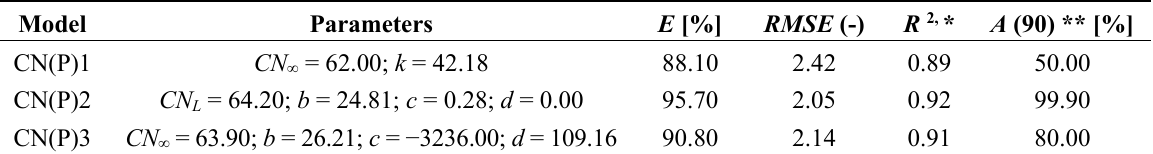
Table 3. P - CN obs parameters of different models and the quality of calculation-observation fit in the watershed